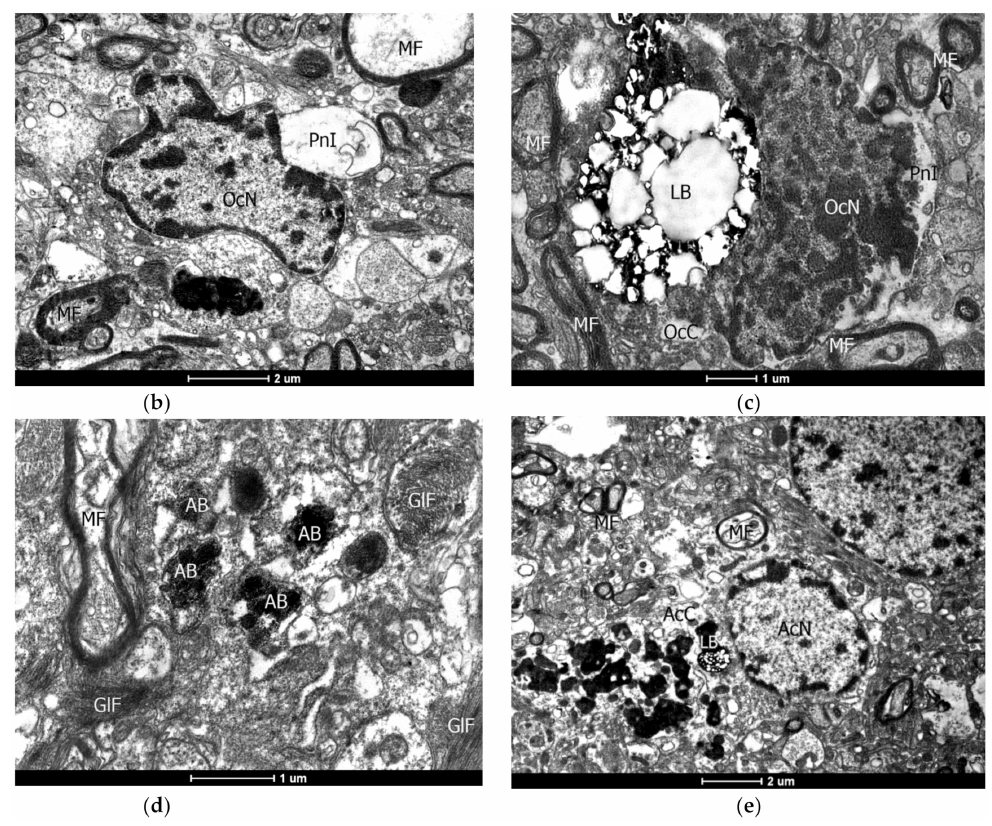
Figure 3. Apoptosis of neurons and oligodendroglia in the cerebral cortex with the formation of perinuclear inflation (PnI). TEM: ( a ) vacuoles and perinuclear inflation in an apoptotic neuron (N); bar, 2 µ m; ( b ) perinuclear inflation in the oligodendrocyte; bar, 2 µ m; 8200 × ; ( c ) apoptosis of oligodendrocyte at the stage of nuclear disintegration with a Lewy body (LB) in the cytoplasm (OcC), on the side of the rupture of the nuclear envelope has many fragments of nuclear matter. MF, myelin fiber; NN, neuron nucleus; OcN, oligodendrocyte nucleus; PnI, perinuclear inflation; bar, 1 µ m; 9900 × .; ( d , e ) formation of apoptotic bodies (AB) and their utilization: ( d ) apoptotic bodies in the intercellular space; bar, 1 µ m; 16,500 × ; ( e ) astrocyte (Ac), performing the function of a macrophage, with a large accumulation of cellular degradation products, lipofuscin granules (Lf) and Lewy body (LB) in the astrocyte cytoplasm (AcC); AcN, astrocyte nucleus; Glf,glyofibrils; MF, myelin fiber; bar, 2 µ m; 6000 ×